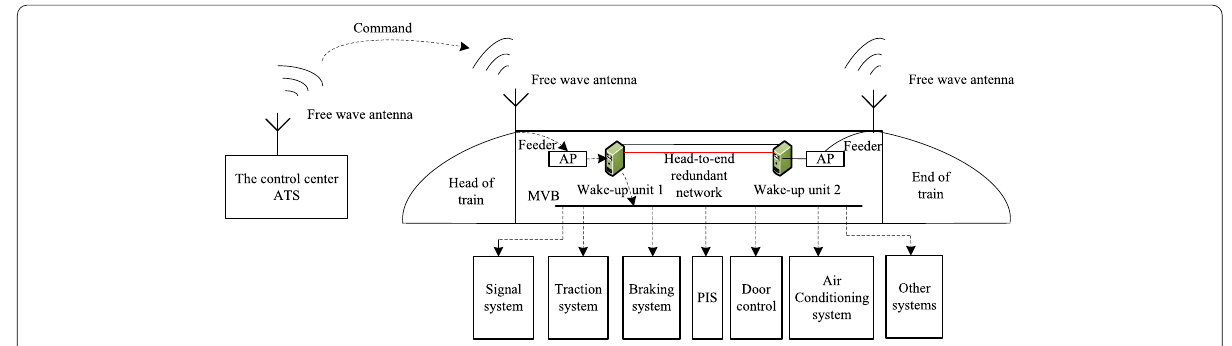
Figure 5 Structure of automatic sleeping and wake-up system for fully automatic